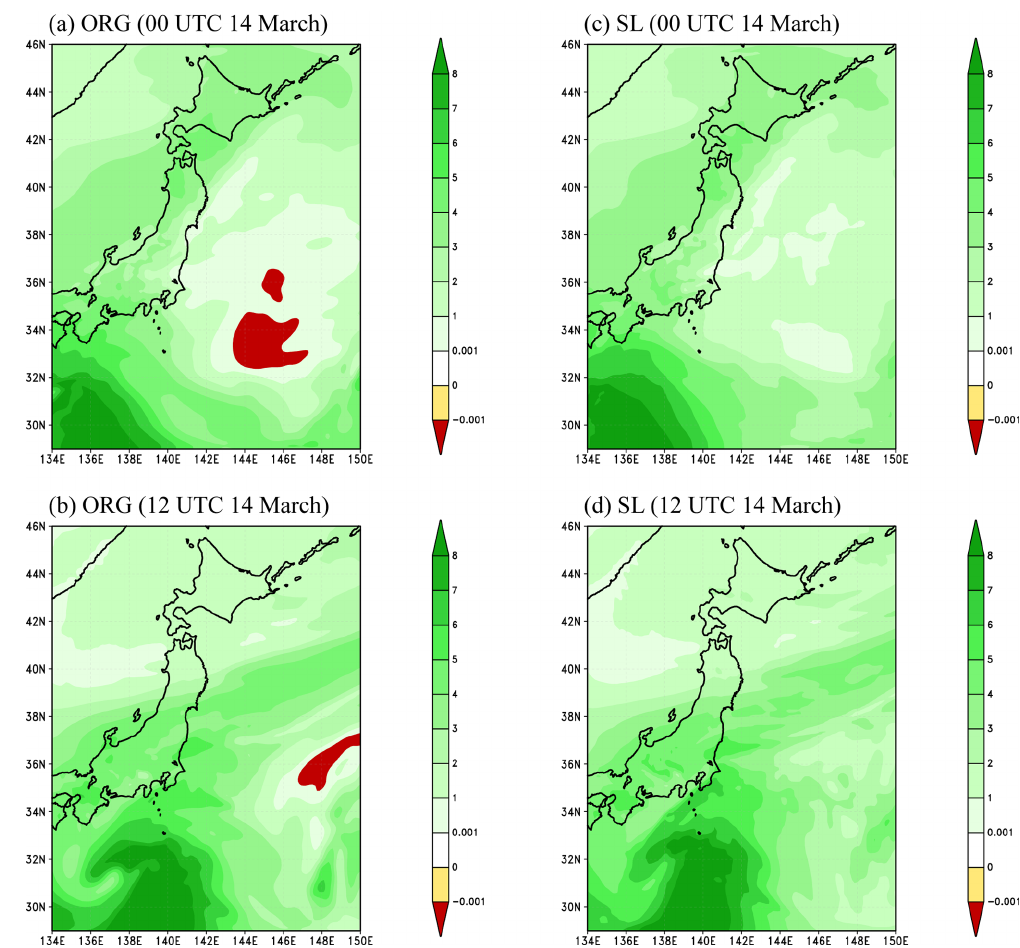
Figure 8. Specific humidity (gkg − 1 ) at 850hPa from the (a, b) ORG and (c, d) SL runs at 00:00 and 12:00UTC, 14 March 2011,